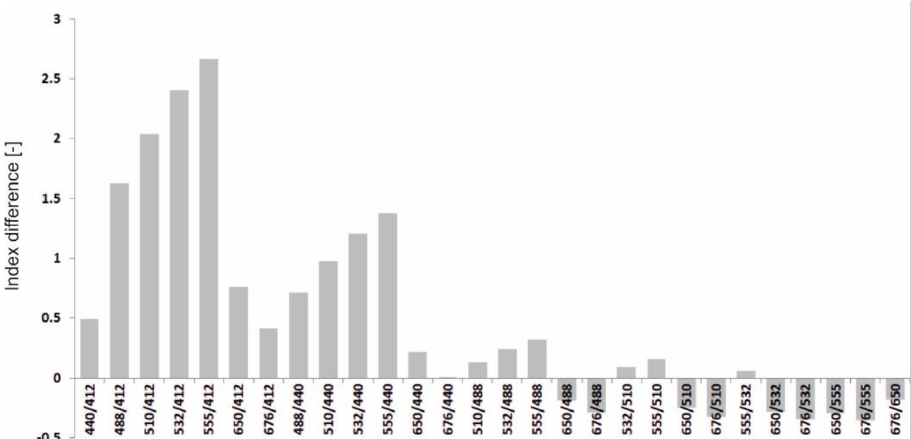
Figure 2. Differences between the values of spectral indices of water polluted with dispersed oil and values of indices of oil-free water. In the case analysed in this paper, a layer of oily water at a depth of several meters would not be